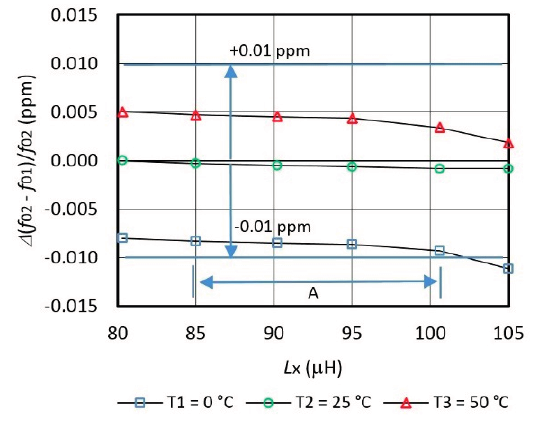
Figure 5. Switching mode compensated oscillator`s frequency Δ ( f 01 − f 02 )/ f 02 characteristics variation depending on the temperatures T 1 , T 2 and T 3 and on L x ( C 10 = 8 pF, L ref = 85 µH, f Syn = 1 Hz).